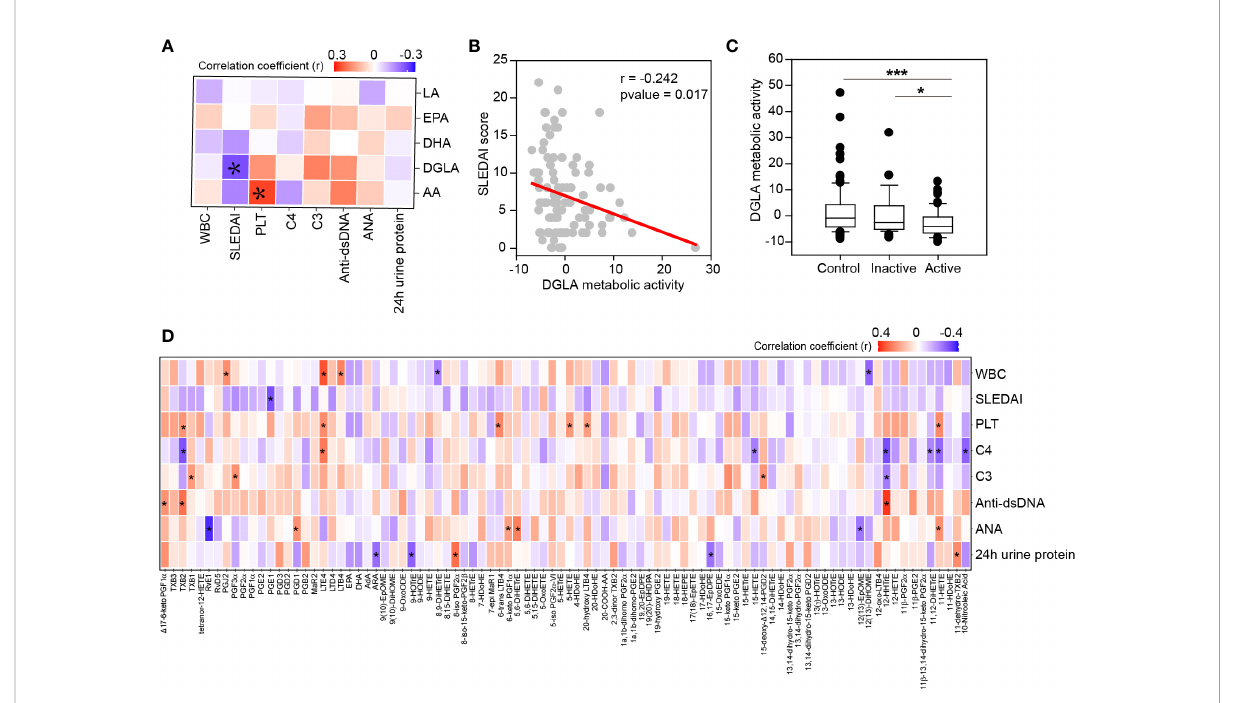
FIGURE 4 Clinical relationship of oxylipins with disease activity descriptors. (A) Heatmap of correlation matrix between PUFAs metabolic activity and disease activity descriptors. Signi fi cant correlations were labeled. Red, positive correlation; Blue, negative correlation. PLT, platelet count; WBC, leukocyte count. *, p-value<0.05. (B) Correlation of DGLA metabolic activity with SLEDAI score by linear regression. The correlation coef fi cient (r) and p-value were also showed. (C) DGLA metabolic activity among active patients, inactive patients and healthy controls. *, p-value<0.05 and ***, p-value<0.001 by rank-sum test. (D) Spearman ’ s correlation between individual oxylipin and disease activity descriptors. Red, positive correlation; Green, negative correlation. *,